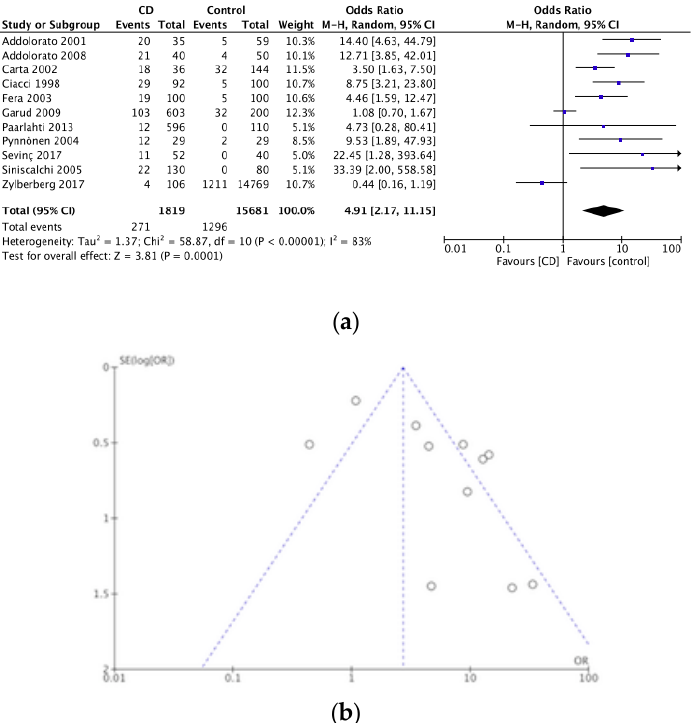
Figure 4. ( a ) Forest plot of pooled prevalence of depression in CD. ( b ) Funnel plot investigating distribution in depression studies.